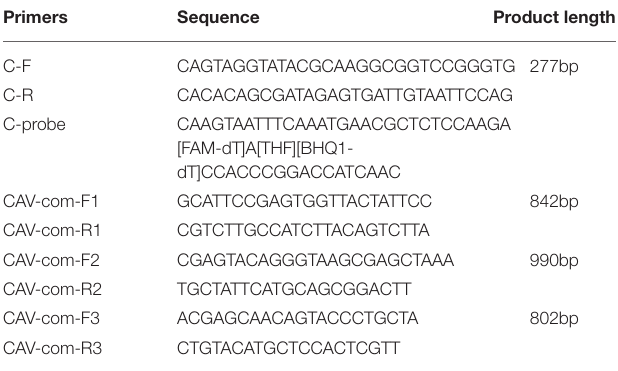
TABLE 1 | Sequence of primers used in this